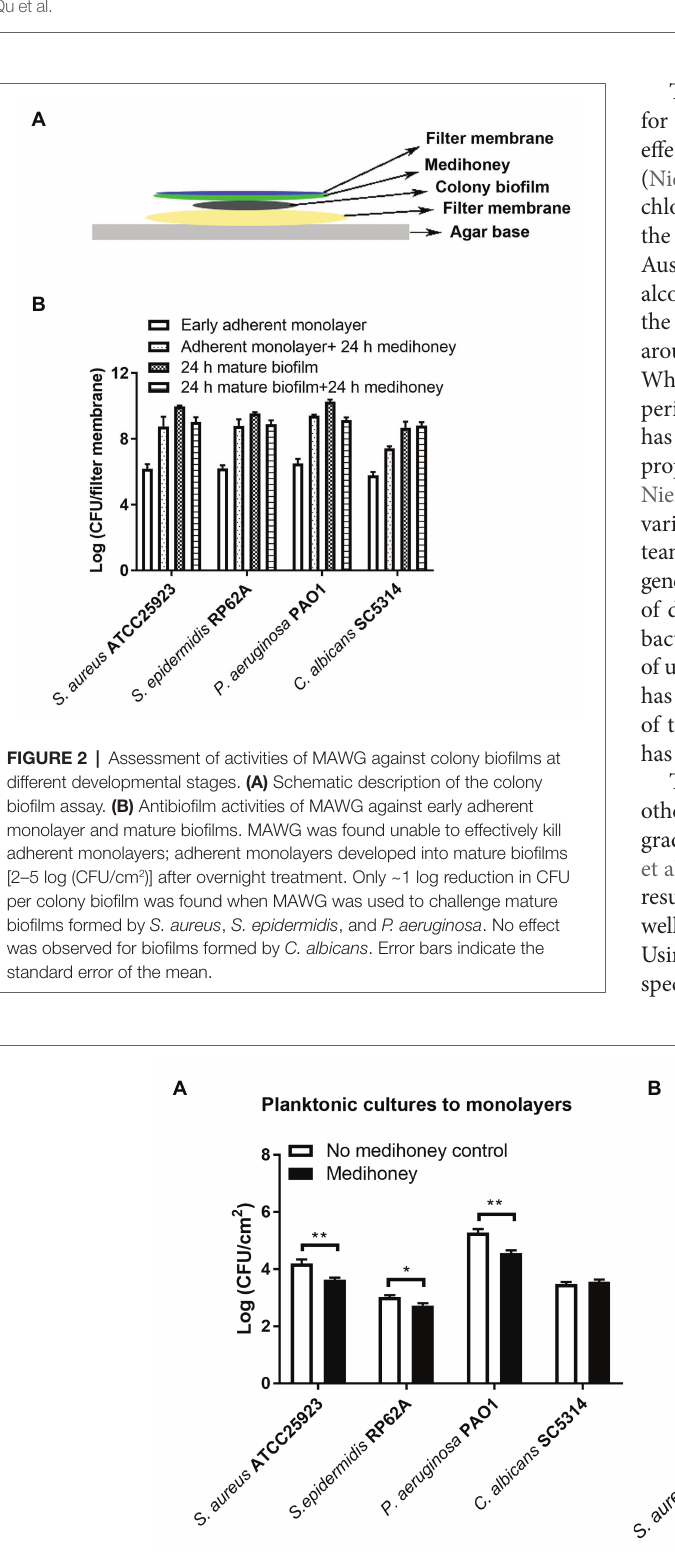
FIGURE 3 | Determination of anti-biofilm activity of MAWG using a drip-flow biofilm reactor and driveline materials. (A) Adherent monolayers of microorganisms were formed on driveline smooth tube cut-outs pre-conditioned with MAWG. Driveline cut-outs received no treatment were used as a control. (B) Adherent monolayers formed on driveline cutouts (without MAWG conditioning) were transferred into a drip-flow biofilm reactor for further cultivation. Driveline cutouts with microbial monolayer were placed on absorbent pads infused with or without MAWG. Biofilm formation on driveline cutouts were assessed by viable counts after 72 h. Error bars indicate the standard error of the mean. * p < 0.05; ** p < 0.01.